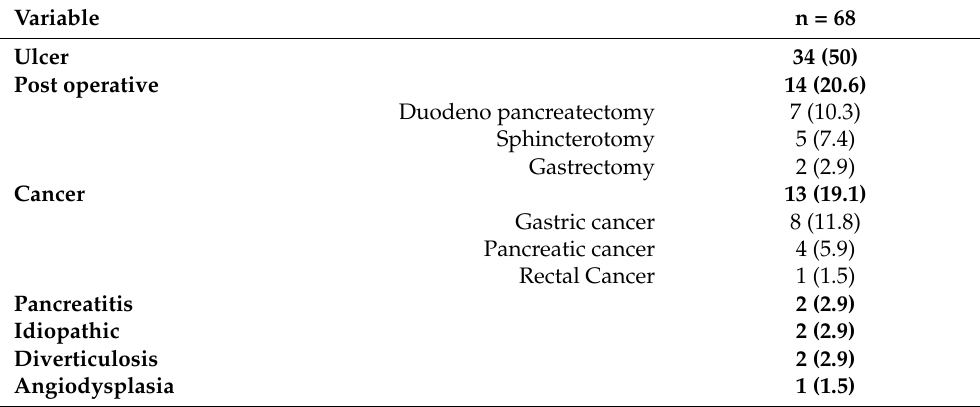
Table 2. Causes of bleeding in the study